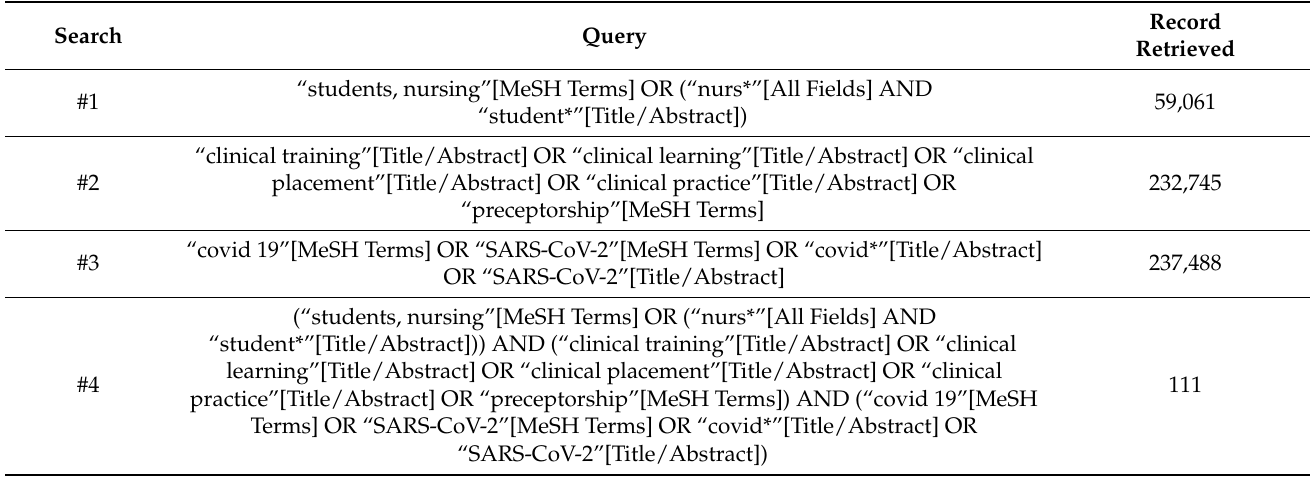
Table 1. Search strategy for MEDLINE (via Pubmed) conducted on 28 March